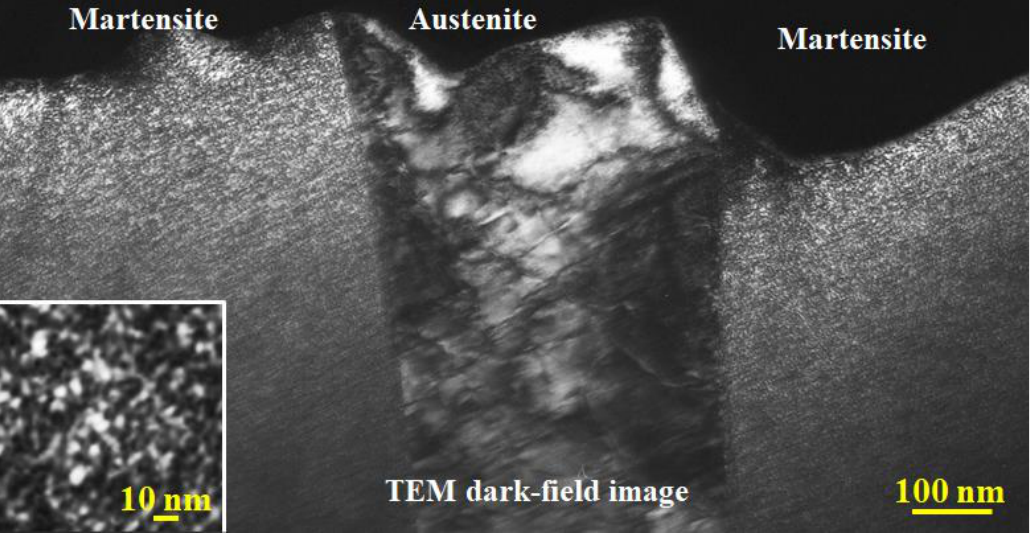
Figure 3. TEM dark field image revealing that the substructure in quenched martensite and retained austenite is different.